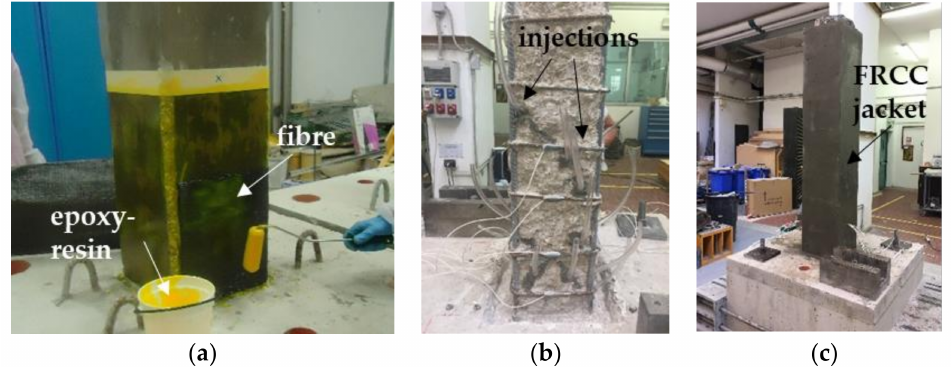
Figure 2. ( a ) CFRP application; ( b ) epoxy-resin injections; ( c ) FRCC